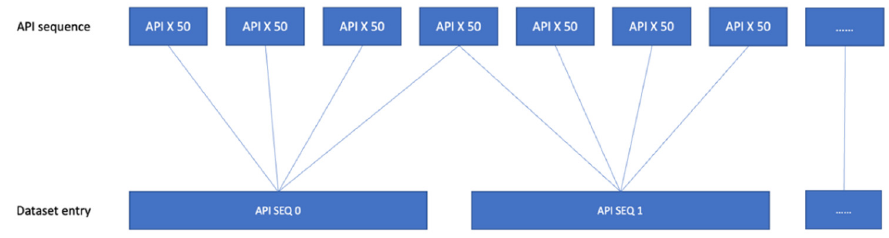
Figure 6. Schematic diagram of API sequence dataset entry division.